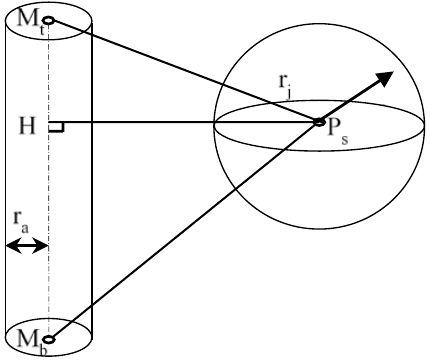
Figure 3. Collison check between a sphere and a capsule.